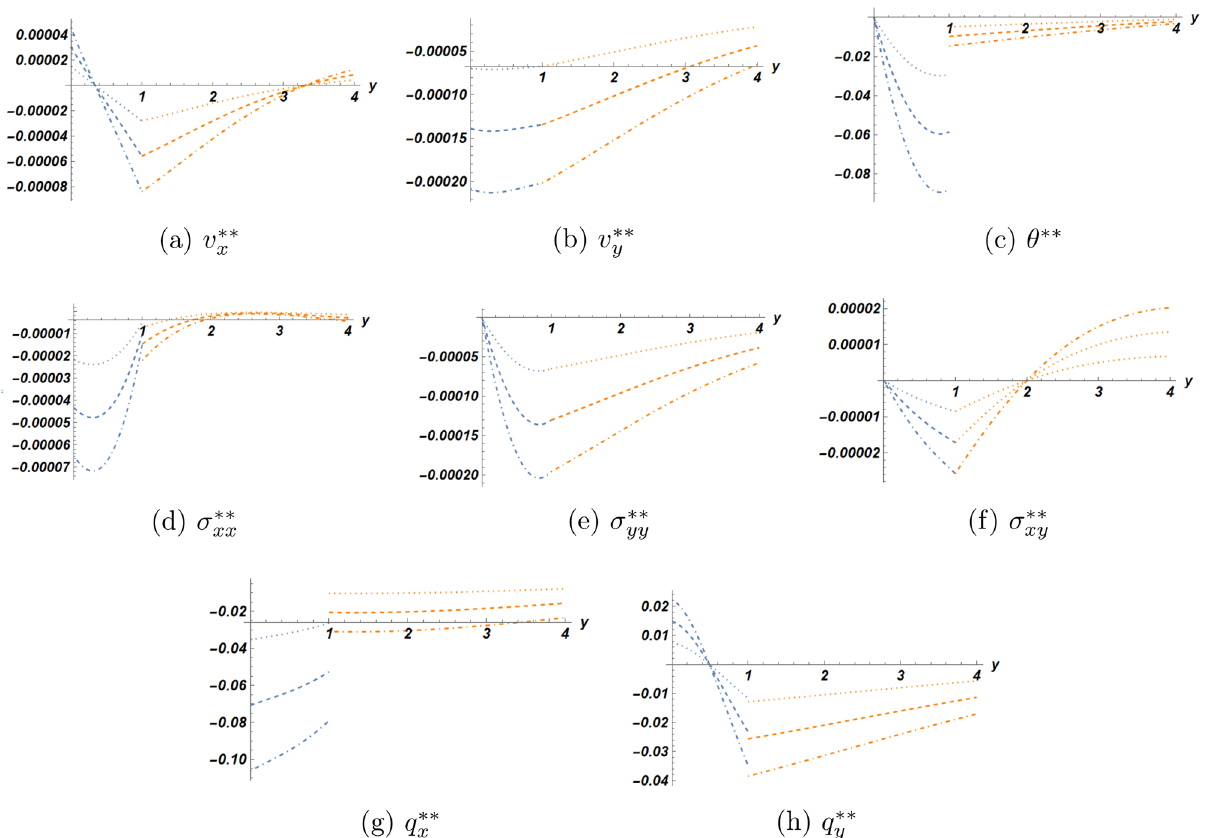
Figure 3. Second order solution as function of y at x = 2.0 , t = 2.1 for three values of η (blue dot) half-space (orange dot) slab (blue dot line) η = 1 (orange dashed line) η = 2 (orange dashed line with dots) η = 3